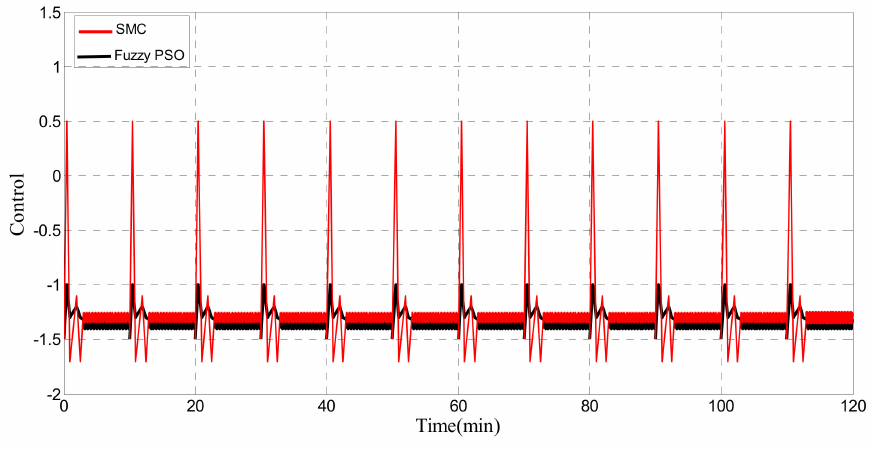
Figure 15. Control input signal. Table 4. A comparative